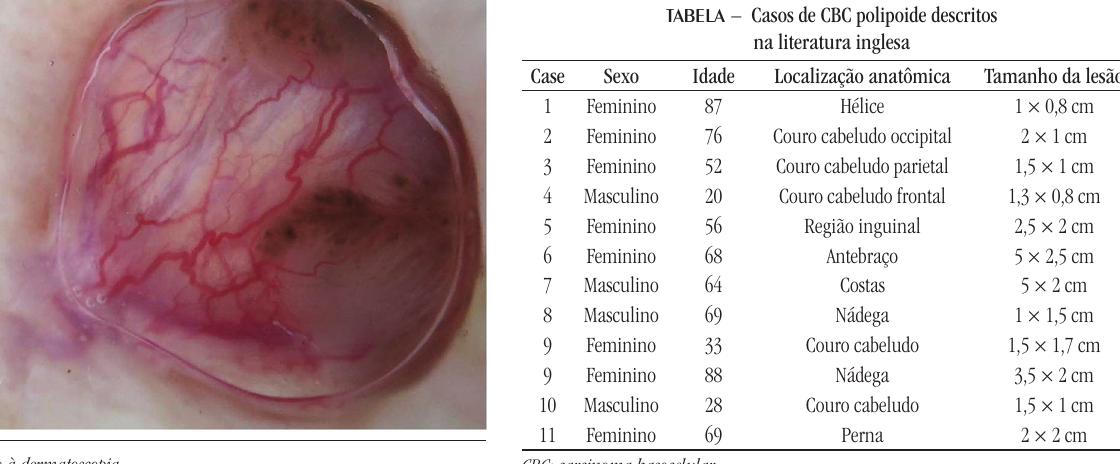
figura 2 − Lesão à dermatoscopia